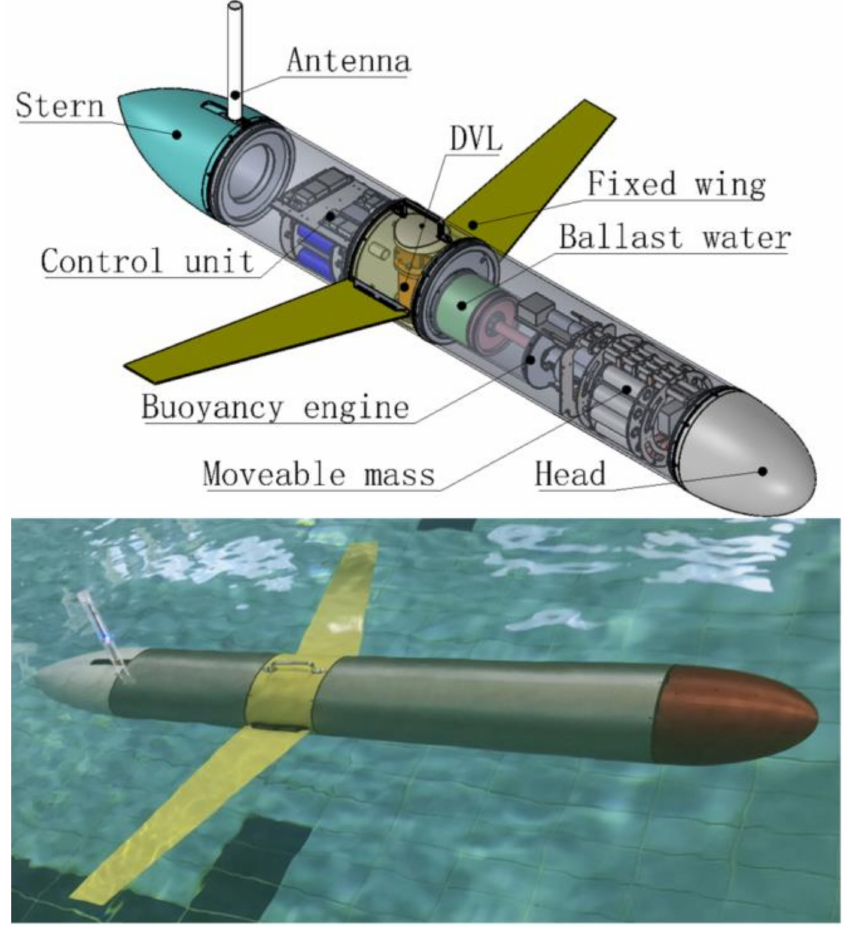
Figure 1. Developed glider and schematic diagram of glider components [16].